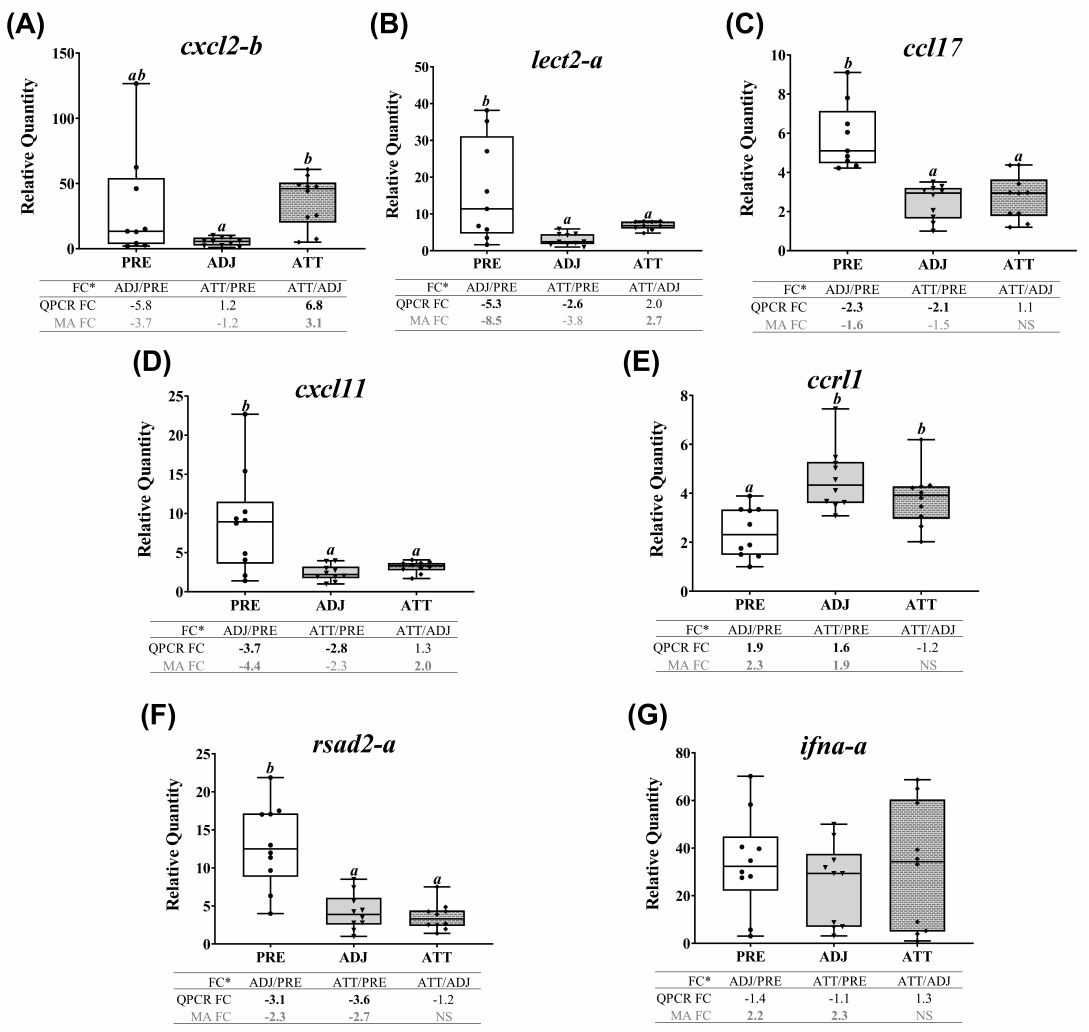
Figure 9. QPCR confirmation of selected microarray-identified transcripts in themes 3 and 4 (Tables 2 and 3). Transcript abundance of selected transcripts associated with chemotaxis and signaling (theme 3), and antiviral response (theme 4). For details of the captions, please refer to Figure 7, (* cxcl2 (alias mip2 , macrophage inflammatory protein 2) also demonstrates homology with cxcl8 / interleukin 8 ( il8